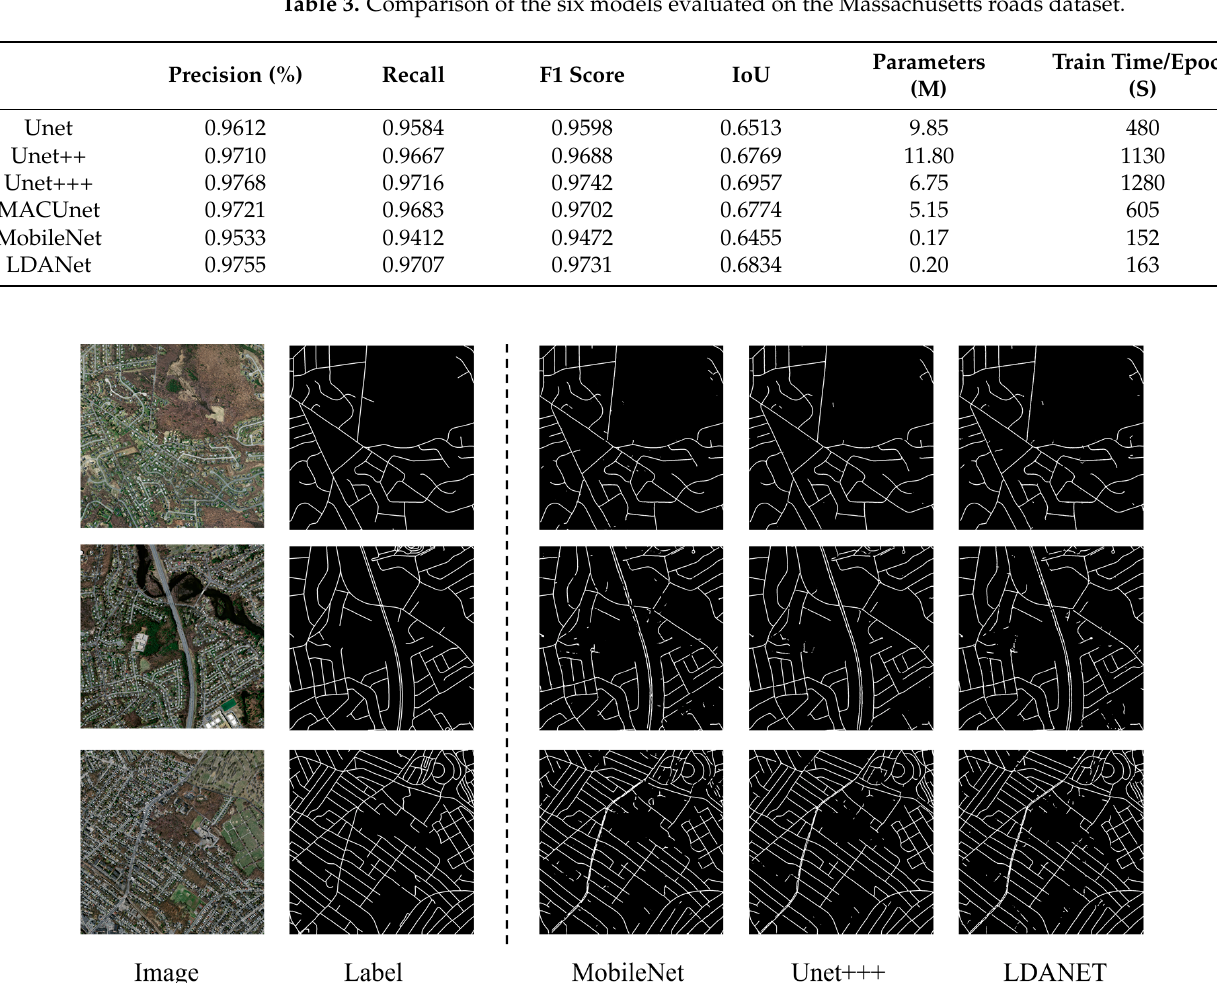
Table 3. Comparison of the six models evaluated on the Massachusetts roads dataset.